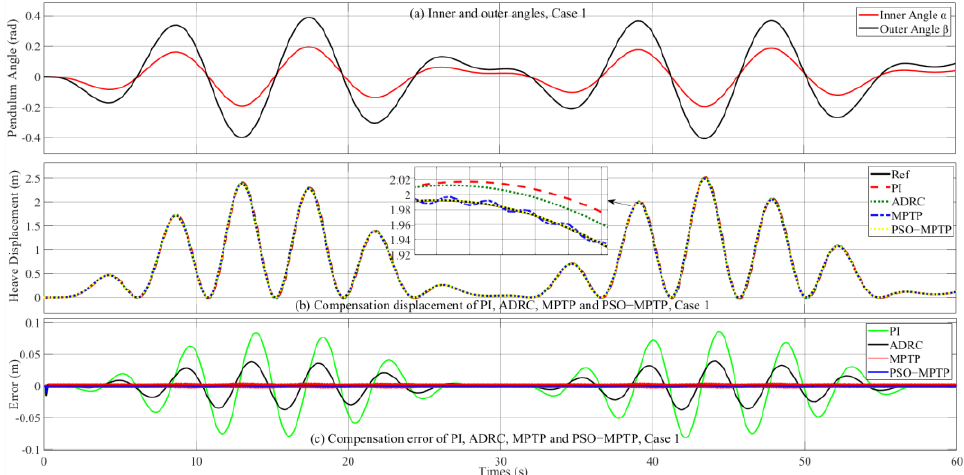
Figure 9. ( a ) Inner and outer angles, Case 1. ( b ) Compensation displacement of PI, ADRC, MPTP, and PSO − MPTP, Case 1; ( c ) Compensation error of PI, ADRC, MPTP, and PSO − MPTP, Case 1.